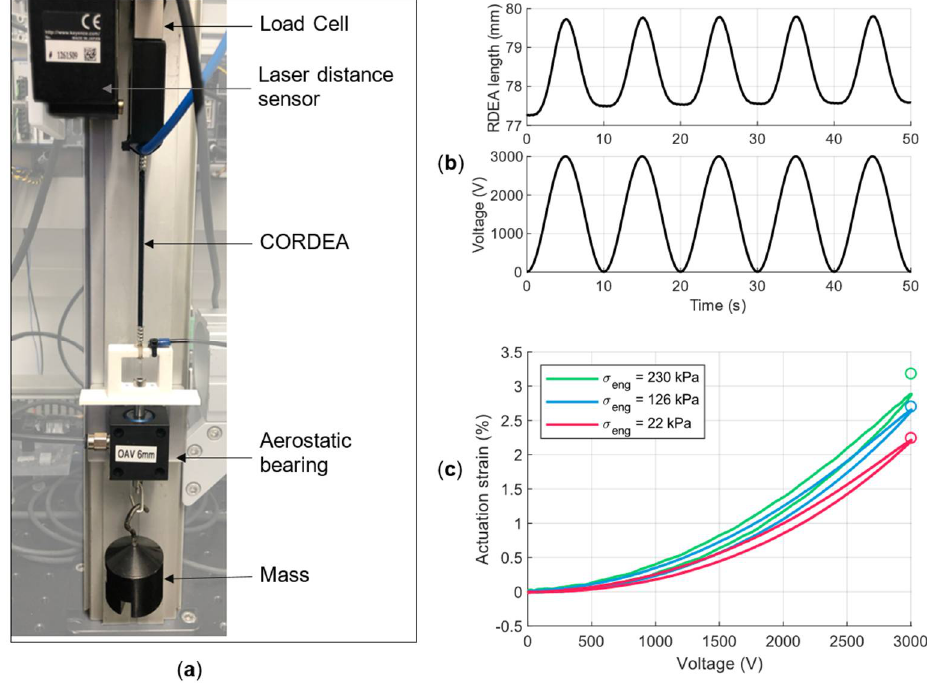
Table 3. Comparison of measured and expected strains.